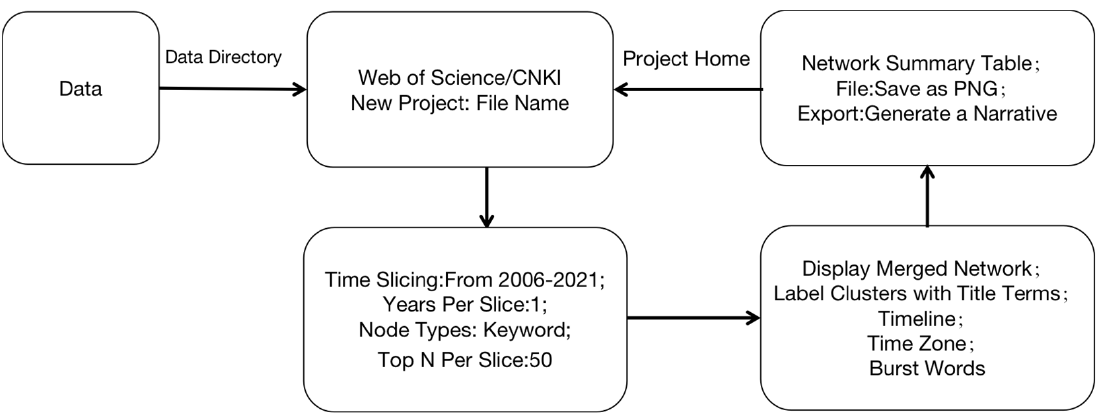
Figure 3. Major visual analytic paths supported by CiteSpace.